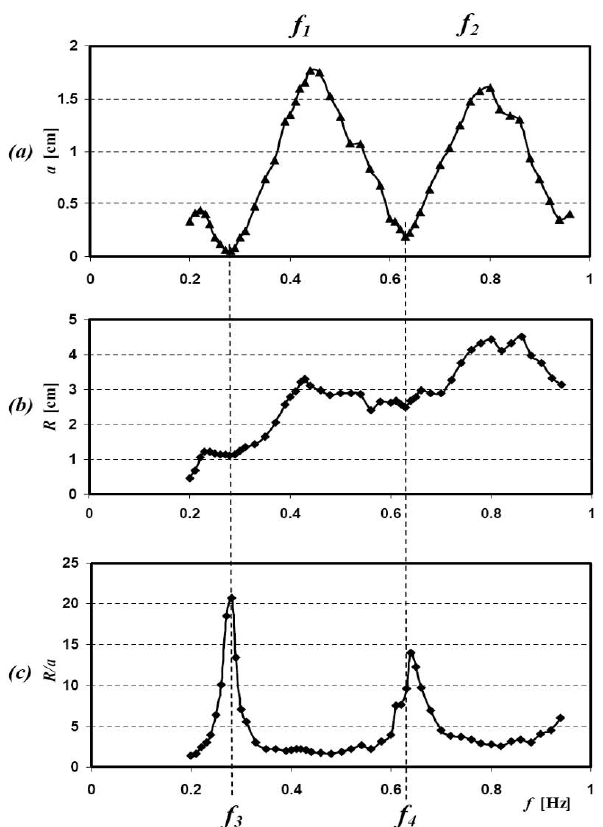
Fig. 3. Frequency dependence of amplitude on free surface dis- placement (resonance curve) (a) , maximal run-up (b) and ampli- fication of run-up (ratio of the maximal run-up and the amplitude of surface wave) (c) for slope tan α = 0 . 263.